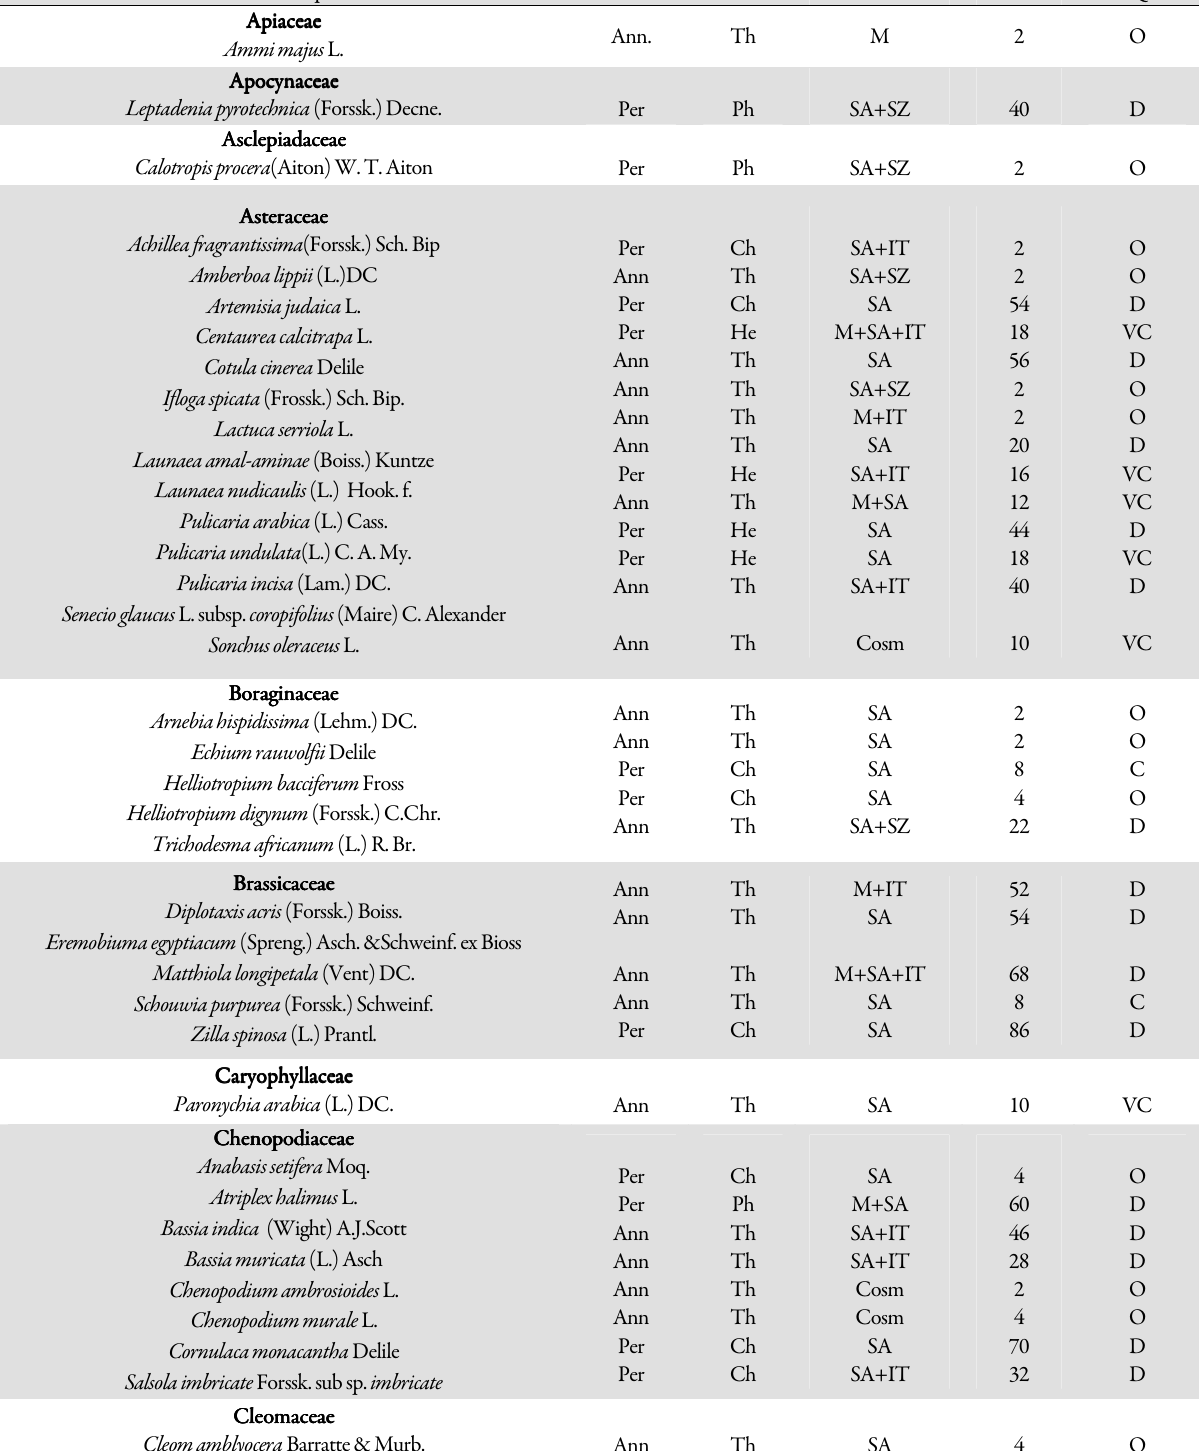
Tab. 1. Species composition of the study area classified according to the different families, together with their presence values